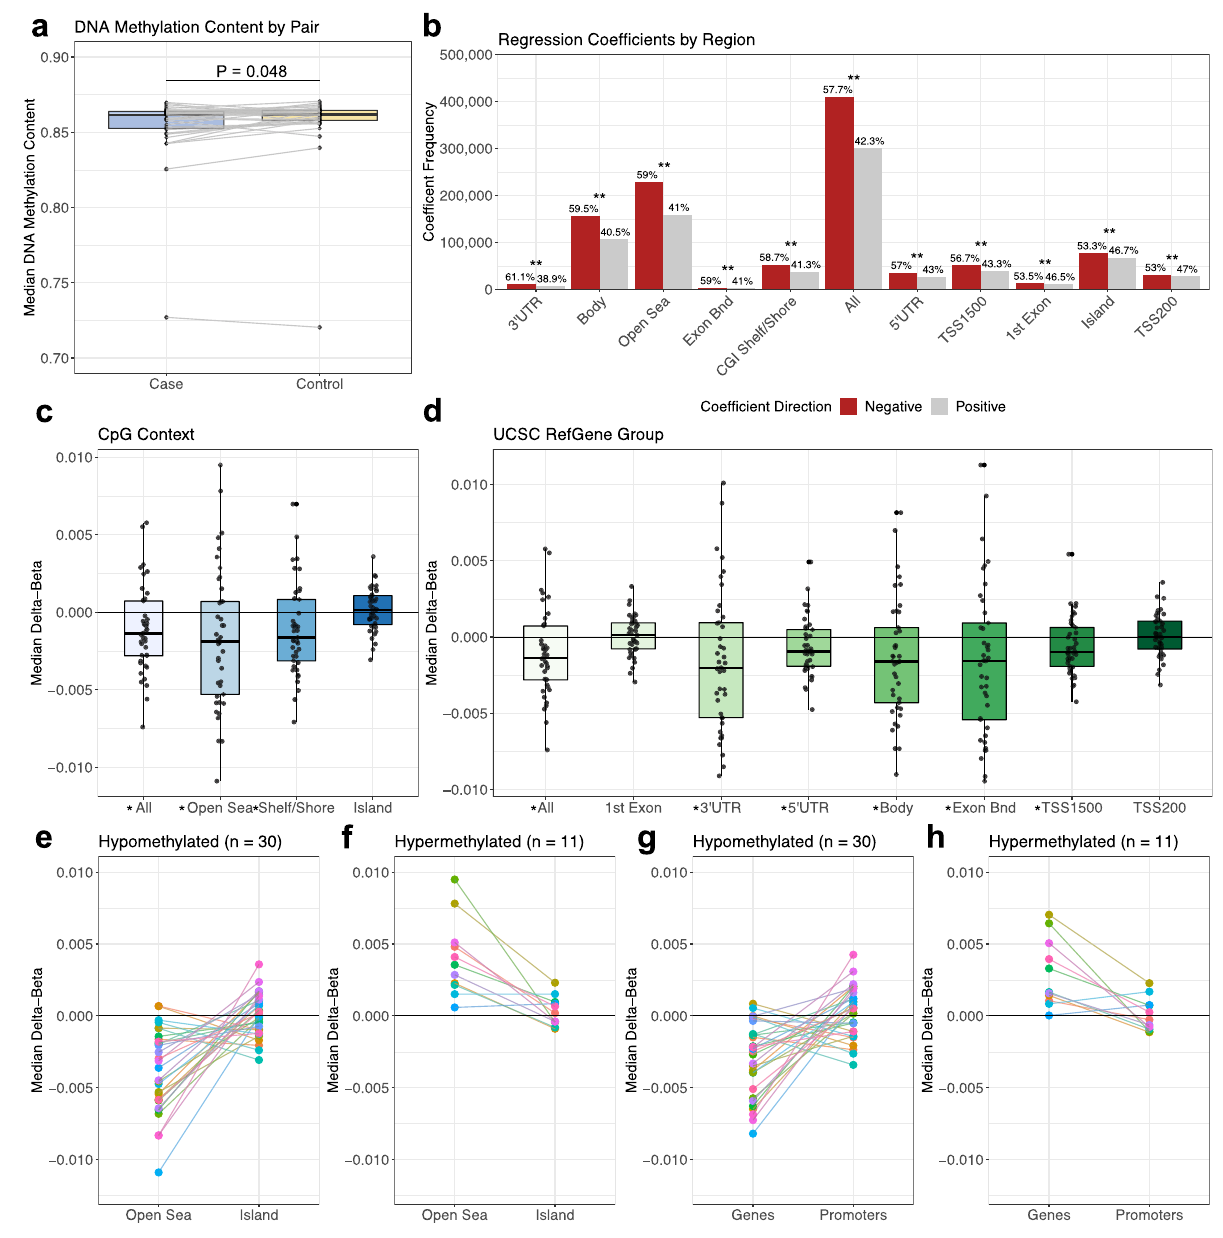
Fig. 2 | Bias in negative coef fi cients from regression analysis indicates region- ally speci fi c DNAhypomethylationpro fi lein ALLcases.a Box and whiskerplots demonstrate median DNA methylation content in n =41 case and n =41 control twins (pairs connected by gray lines). Signi fi cantly lower global DNA methylation was identi fi ed in the case of twins when compared to their sibling controls (Two- sided paired Wilcoxon test P =0.048). b Bar plot demonstrating proportion of positive (indicating hypermethylation in cases) and negative (indicating hypo- methylation) regression coef fi cients in all probes, by CpG island context, and by genetic context. The percentage of positive and negative probes are shown over bars. All regions are signi fi cantly biased toward negative regression coef fi cients. Regions are arranged by the strength of negative coef fi cient bias, with CpGs in 3 ′ - UTR,genebody,opensea,exonboundaries(ExonBnd),andCpGislandshelf/shore regions showing a stronger negative bias thanthe overall array results. **indicates FDR-corrected P <0.001. Evaluation of DNA hypomethylation signature identi fi ed in conditionalregression analysisusing raw beta valuespaired bytwin relationship (delta beta, or ALL-case DNA methylation beta value minus control beta value) accordingto c CpGcontextand d UCSCRefGeneGroupfor n =41independenttwin pairs. *FDR-corrected P <0.05. The distribution of median delta beta values (case